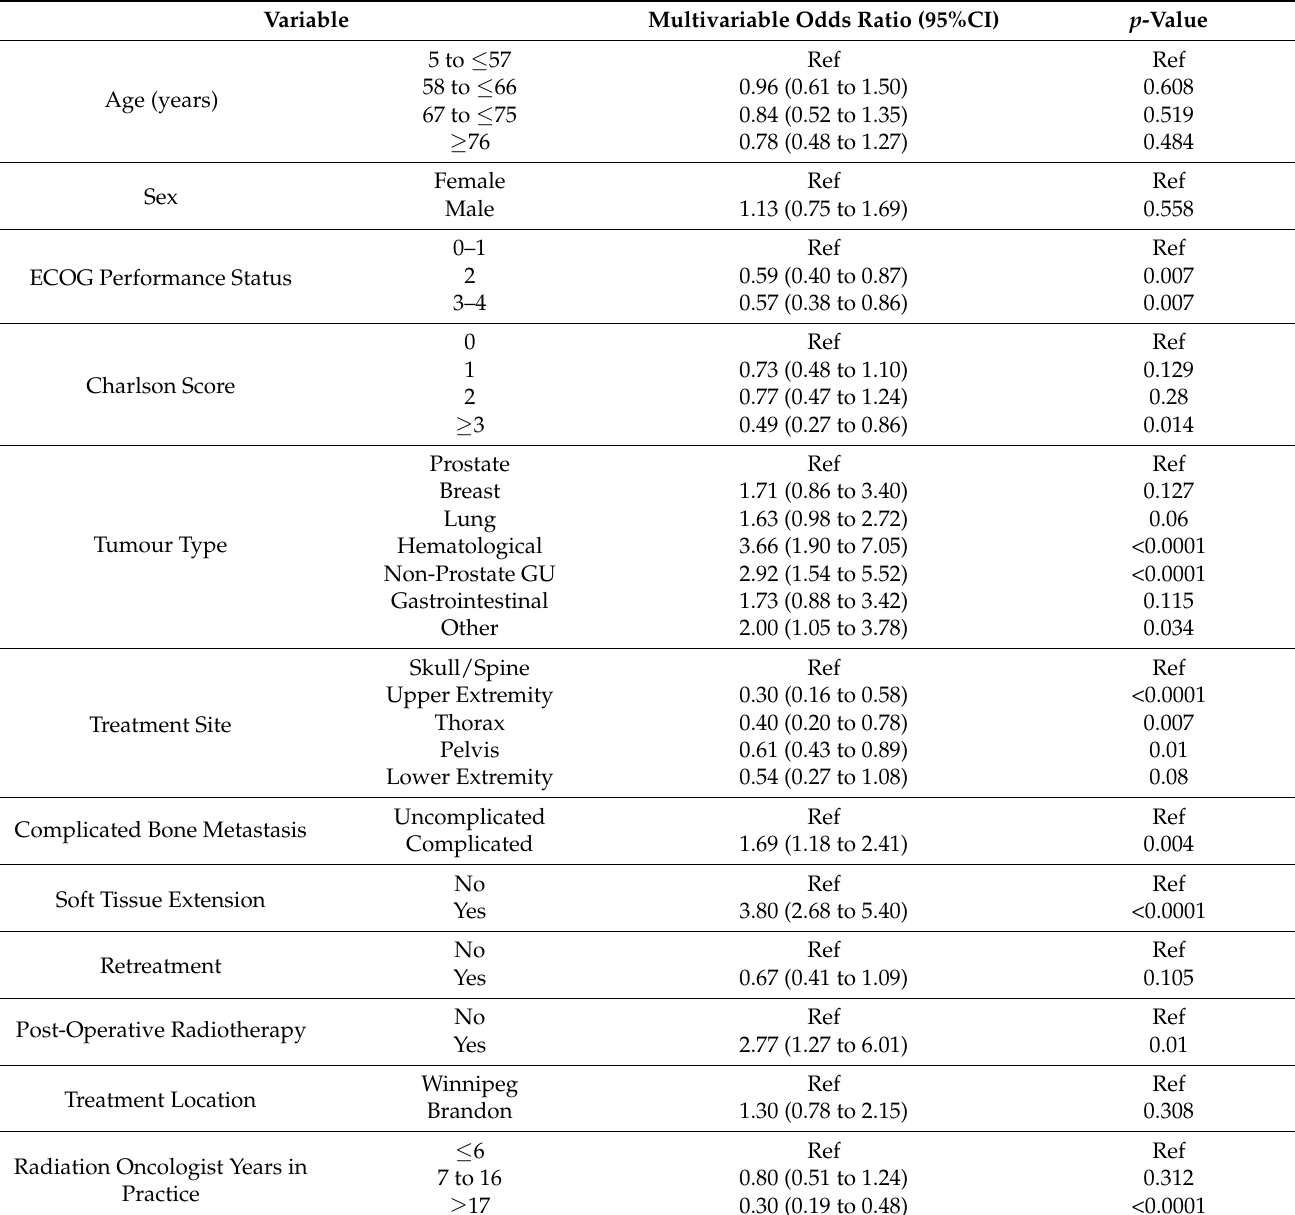
Table 4. Multivariable Logistic Regression Analysis for Receipt of MFRT in 2018 (Model 1) (GU: Genitourinary; ECOG: Eastern Cooperative Oncology